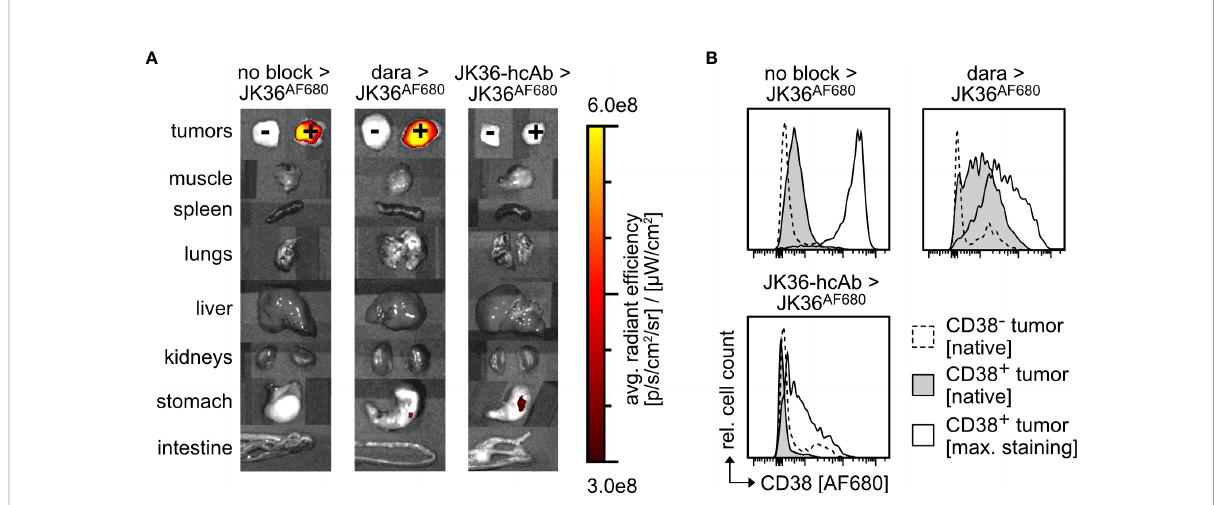
FIGURE 6 Ex vivo analyses of cells from CD38 + and CD38 - tumors explanted from mice 6 hours and 24 hours post-injection of JK36 AF680 . (A) Fluorescence levels of individual tumors and organs explanted from mice pretreated with isotonic saline, daratumumab, or JK36-hcAb 6 hours after injection of JK36 AF680 . (B) Histograms depicting median fl uorescence intensities of the AF680 channel in mice after pretreatment with isotonic saline, daratumumab, or JK36-hcAb, obtained from tumors explanted 24 hours after injection of JK36 AF680 . Dashed histograms represent native AF680 signals of the CD38 - control tumor, grey histograms represent native AF680 signals of the CD38 + tumor, open histograms represent the maximum AF680 signal obtained after ex vivo staining of CD38 + tumor cells with JK36 AF680 . Each panel is a representative example of n=10 per treatment group. Cell debris was initially excluded by setting an appropriate FSC-A threshold before gating on single cells. YAC-1 cells were then identi fi ed by co-expression of CD38 (using nanobody JK2, identifying the remaining free epitope of CD38) and